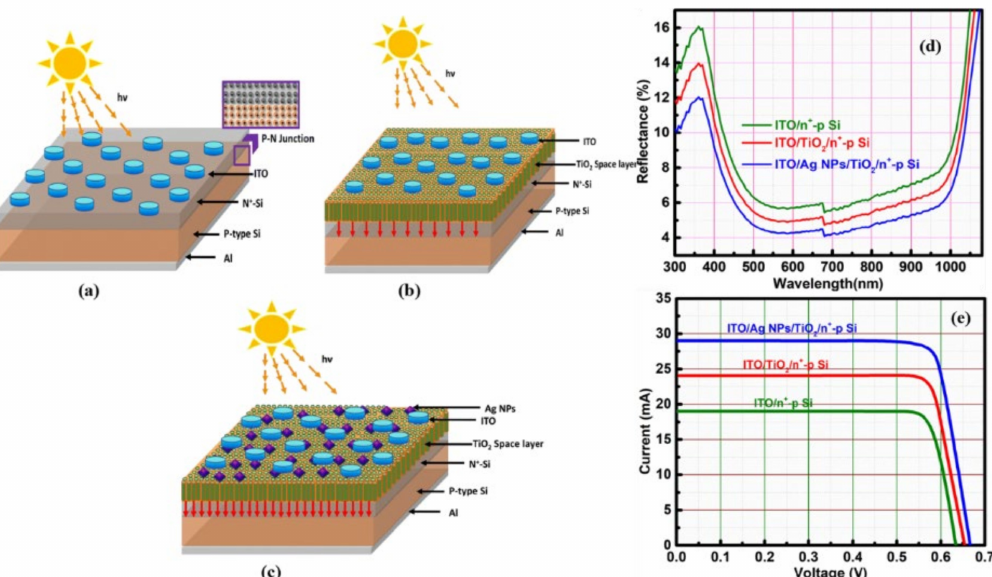
Figure 10. ( a ) Bare thin Si-based solar cell. ( b ) Si solar cell with TiO 2 thin film as ARC. ( c ) Si solar cell with TiO 2 film as ARC and Ag nanoparticles (NPs). ( d ) Reflectance spectra of the three prepared solar cell configurations. ( e ) I/V characteristics of the prepared solar cells [162]. (Reprinted with permission from [162], 2020, Springer Nature and Copyright Clearance